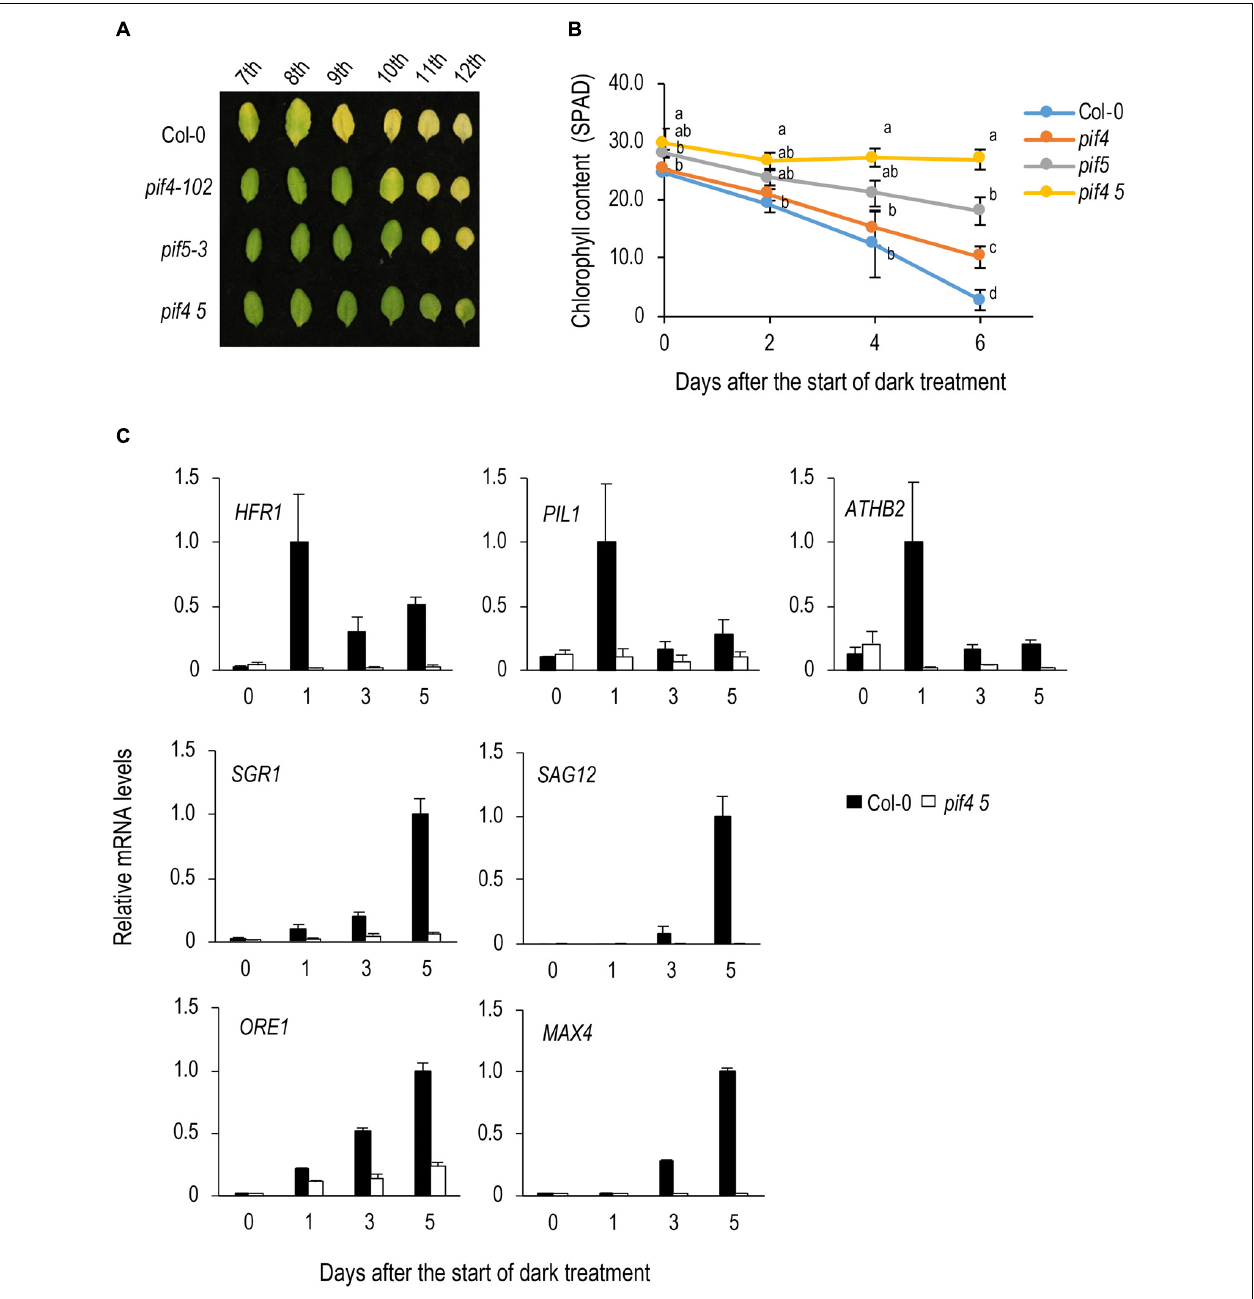
FIGURE 1 | Analysis of the function of PIF4 and PIF5 in dark-induced senescence. (A) Dark-induced leaf senescence in pif4 · pif5 . Leaves in the 7th to 12th positions from the top of 4-week-old plants were incubated in the dark for 6 days. (B) Changes in chlorophyll content over time in pif4 pif5 during dark incubation. Detached 8th leaves were used for the analysis. Data for the same day after the start of treatment were statistically compared using Tukey’s multiple comparison method ( p < 0.05). (C) qRT-PCR analysis of transcript levels of direct target genes of PIF5 and senescence-induced genes. 8th leaves were used for the analysis. Solid and open bars indicate Col-0 and pif4 pif5 leaves, respectively. Transcript levels were relative to that in Col-0 leaves at 5 DAT. ACT8 was used as a reference. Bars indicate standard error ( n = 3).